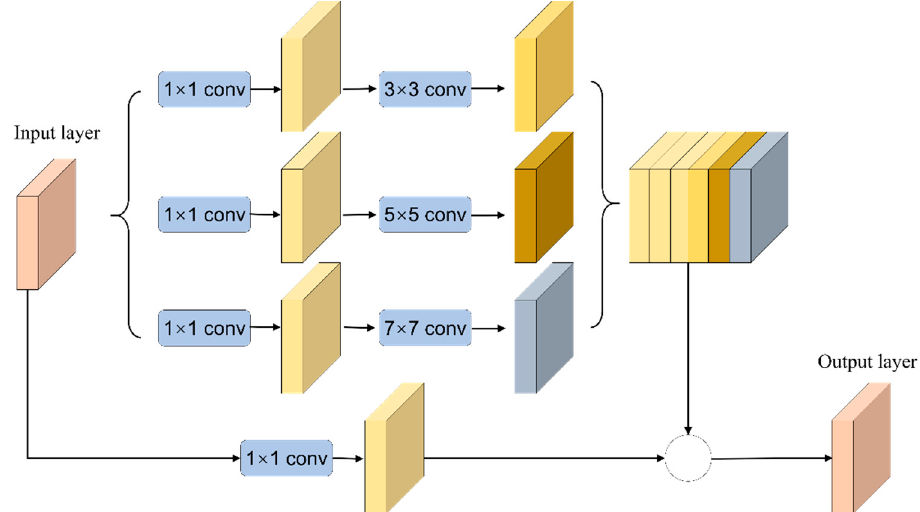
Figure 1. Residual module under multisensory field.